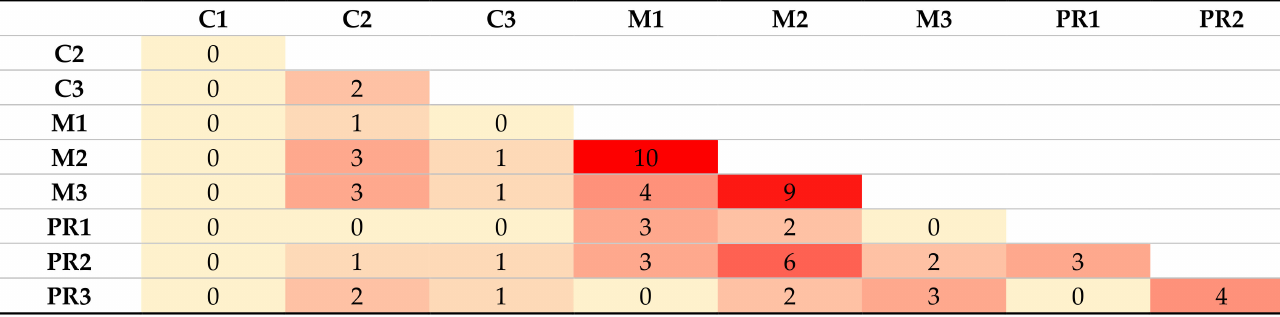
Figure 5. Interactions between two codes within the Irish